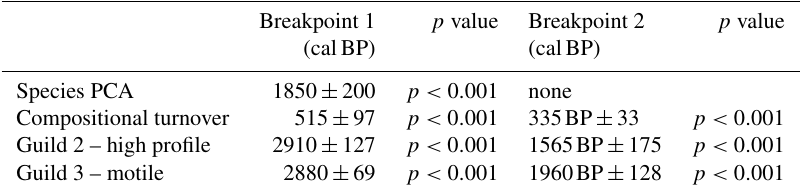
Figure 4. All diatoms were classified into one of four guilds (after Passy, 2007, and Rimet and Bouchez, 2012): low profile (guild 1), high profile (guild 2), motile (guild 3), and planktic (guild 4). Guilds are presented as relative abundances (%) to the left and deviations around the mean to the right. Table 2. Significant breakpoints in diatom trend data ( p < 0 .